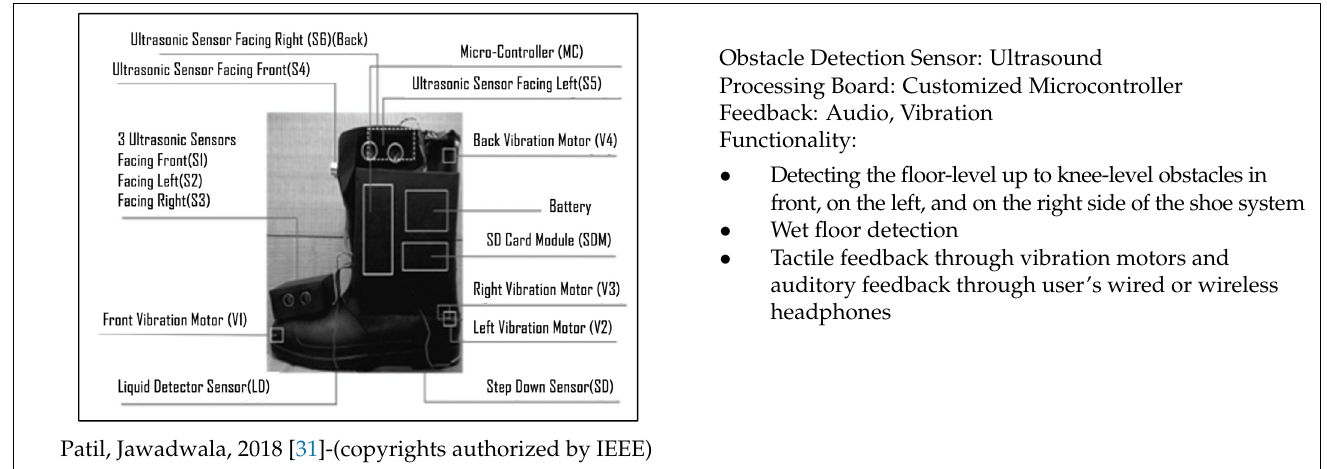
Figure 1. Schematic block diagram illustrating the main components of obstacle detection shoes, as used in the reviewed literature. Table 1. Examples of smart shoe systems selected from the reviewed articles. Only the sensors used for obstacle detection by the shoe systems are listed in this table.